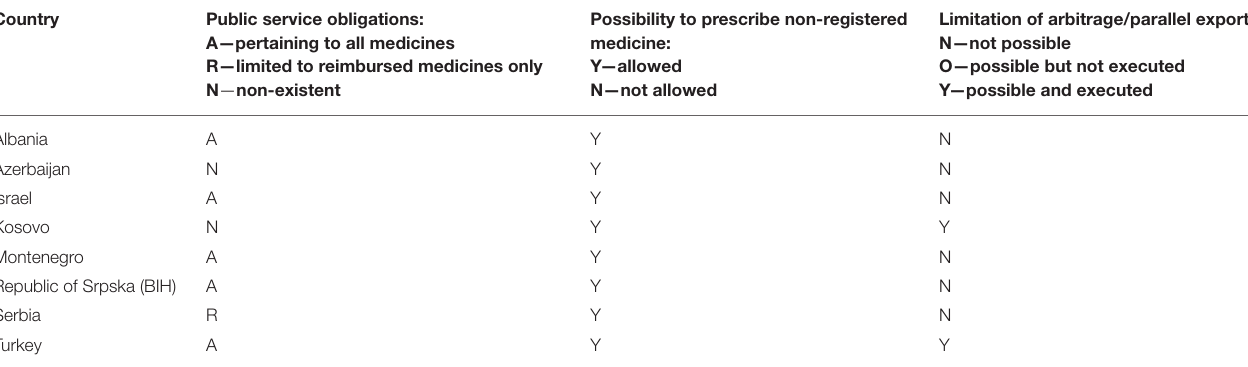
TABLE 6 | The summary information on measures influencing trade rules in countries outside of the area of the European Union and European Free Trade Association.